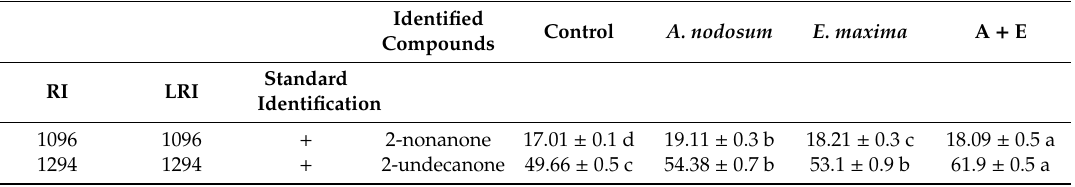
Table 1. Essential oil main chemical constituents (means expressed in percentage) of R. graveolens as a response to seaweed extract treatments. Different letters indicate significant differences among treatments within the same row at p ≥ 0.05. A + E: A. nodosum + E. maxima .